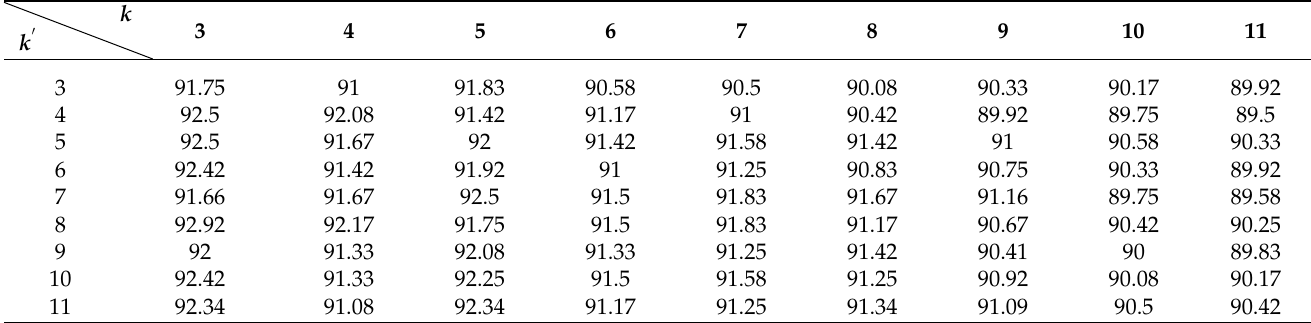
𝑘 -NN-based models utilizing the F1 to F9 feature sets separately are shown in Table 7, the